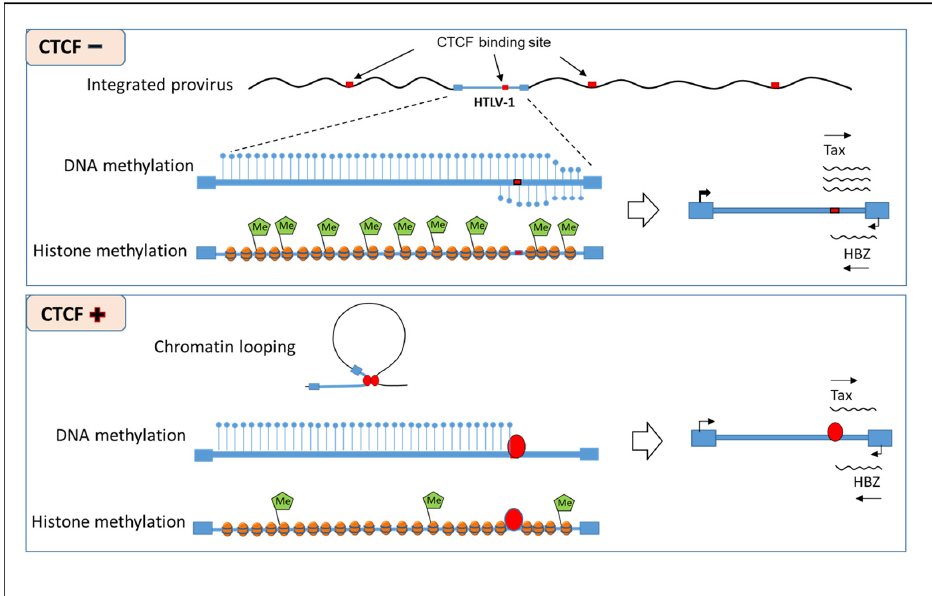
Figure 2. CTCF is a critical boundary element that regulates epigenetic modifications of HTLV-1. CTCF prevents the extension of DNA methylation in the pX and 3 ′ LTR regions on both the sense and antisense strands of the HTLV-1 provirus. The interaction of CTCF and proviral DNA also leads to a lower level of methylation for histone 3, both up- and downstream of the CTCF binding site of the provirus. As a result of these epigenetic modifications, less Tax is expressed.